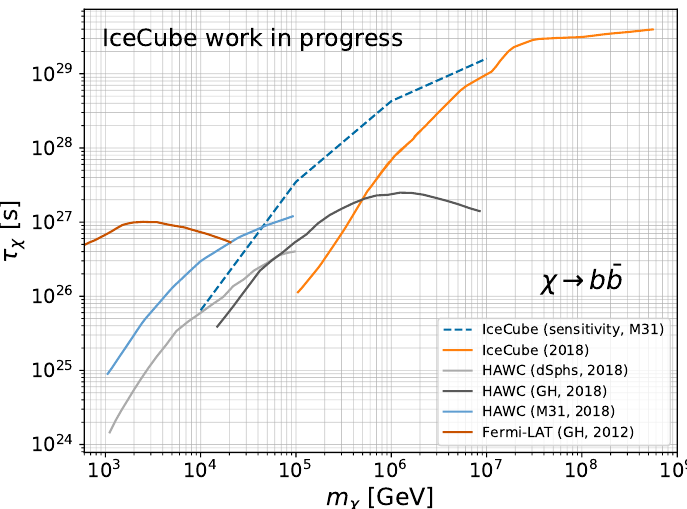
Figure 4. Limits and sensitivity on decaying dark matter life time from different experiments [46–50]. Figure reproduced from [51], credit: IceCube